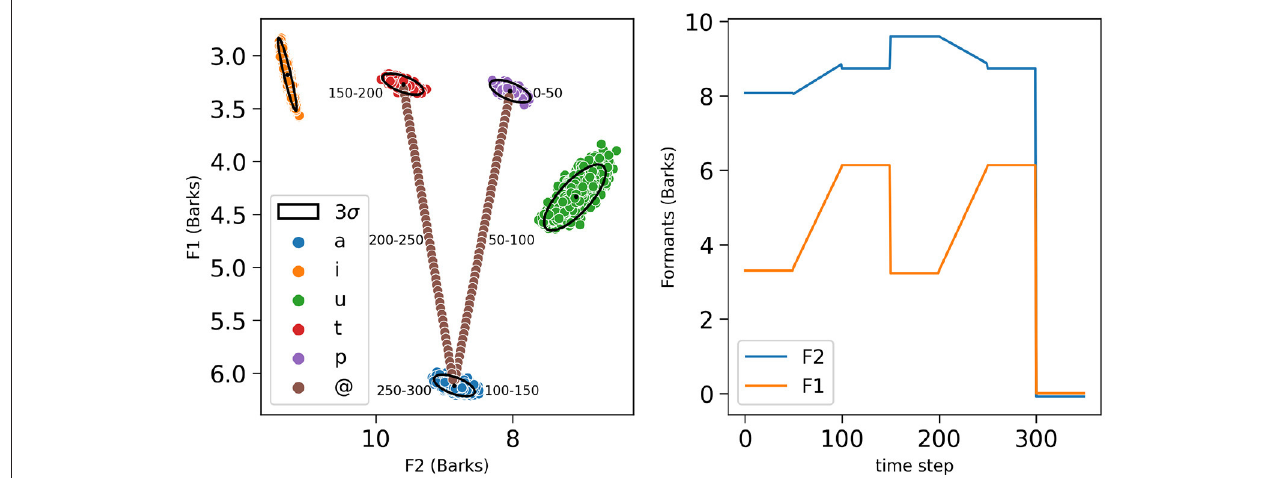
FIGURE 3 | (Left) Phones of the lexicon represented on a two-dimensional space with the second formant F2 on the x -axis from right to left and the first formant F1 on the y -axis from top to bottom, as is classical in phonetic displays. Phones associated with phonemes /a/, /i/, /u/, /t/, and /p/ are, respectively, represented by blue, yellow, green, red and purple colored dots. The trajectory of the simulation of the word “pata,” is also displayed. The annotations correspond to the different corresponding time steps for each constituent phone of the word “pata,” with one sample of the phone p from 0 to 50 time steps, the transitional phone @ between the phones p and a , from 50 to 100 time steps, along a linear transition joining the barycenters of the two phone categories (brown dots), one sample of the phone a from 100 to 150 time steps, one sample of the phone t from 150 to 200 time steps, the transitional phone on 50 time steps, and one sample of the phone a from 250 to 300 time steps. For each phone, are also shown the mean (black dot) and the 3 standard-deviation ellipse of the bi-variate normal distribution best fitting the data points (black ellipses). (Right) Example of formant inputs ( y -axis, in orange for F1, in blue for F2) used for the word “ pata ,” as a function of simulated time steps ( x